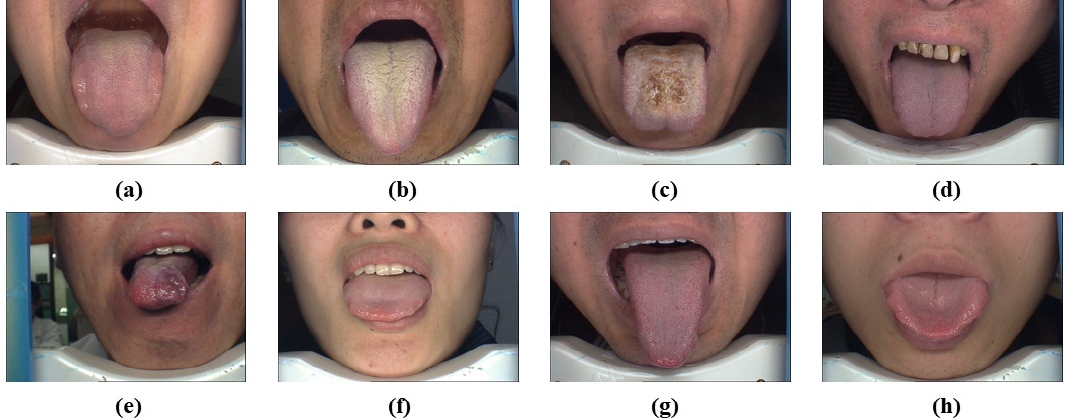
Figure 1. Samples of tongue in images with different circumstances. ( a ) sample of tongue with an apparent gap in the mouth; ( b ) sample of tongue with abnormal color; ( c ) sample of tongue with abnormal texture; ( d ) sample of tongue with teeth showing; ( e ) sample of tongue with irregular poses; ( f ) sample of tongue not completely protruding; ( g ) sample of tongue with teeth imprints on the edges; ( h ) sample of tongue closely surrounded by the